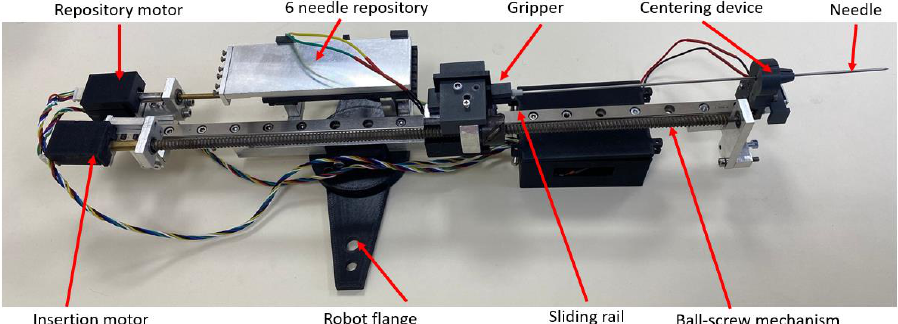
Figure 2. Multi-needle brachytherapy instrument.